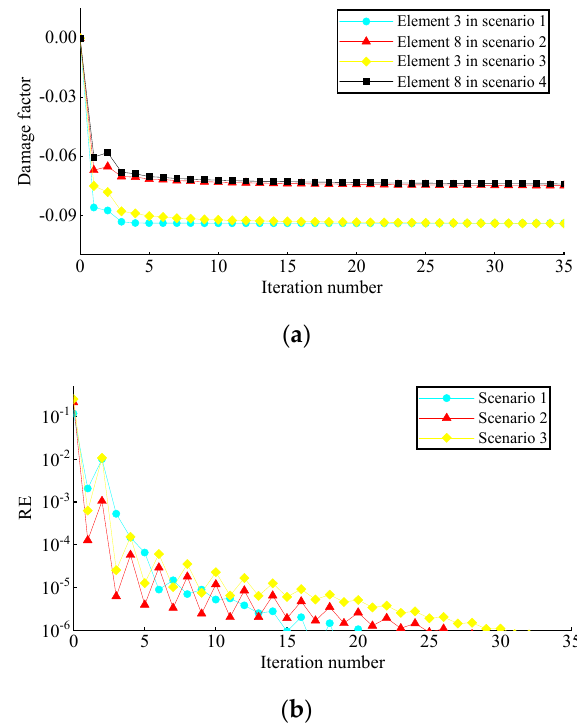
Figure 13. Convergence curve of damage identification: ( a ) damage factor; ( b ) relative error. Table 4. The number of iterations and time consumption for convergence under different damage scenarios.